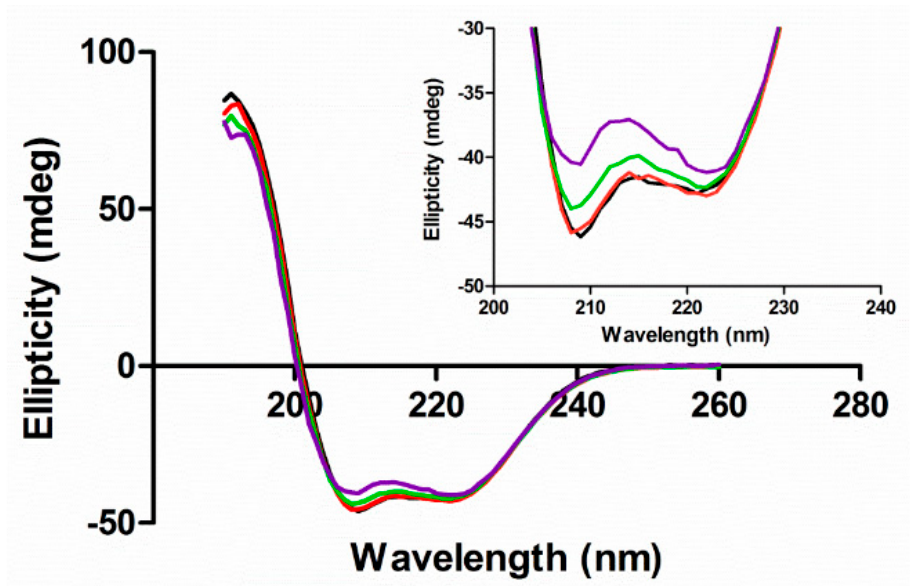
Figure 5. Circular dichroism (CD) spectra of HSA (5 μ M) in the absence and presence of EGCg in 20 mM phosphate buffer at pH 7. The concentrations of EGCg were 0 μ M (black), 25 μ M (red), 50 μ M (green), and 125 μ M (purple).